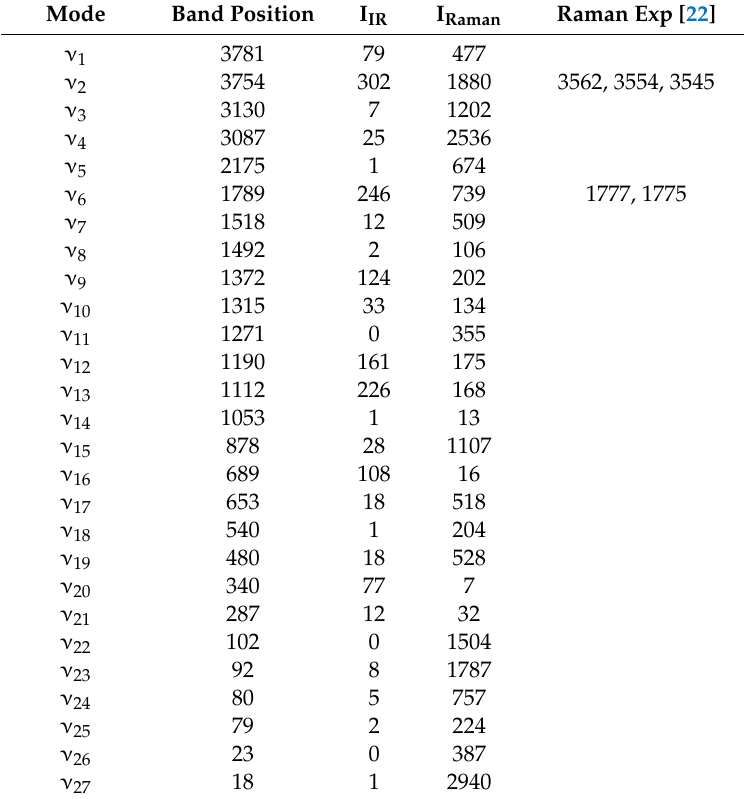
Table 3. Computed band positions for the most stable SSC ··· N 2 complex (SSC1) compared to the experimental Raman band positions (cm − 1 ) together with computed infrared (km mol − 1 ) and Raman